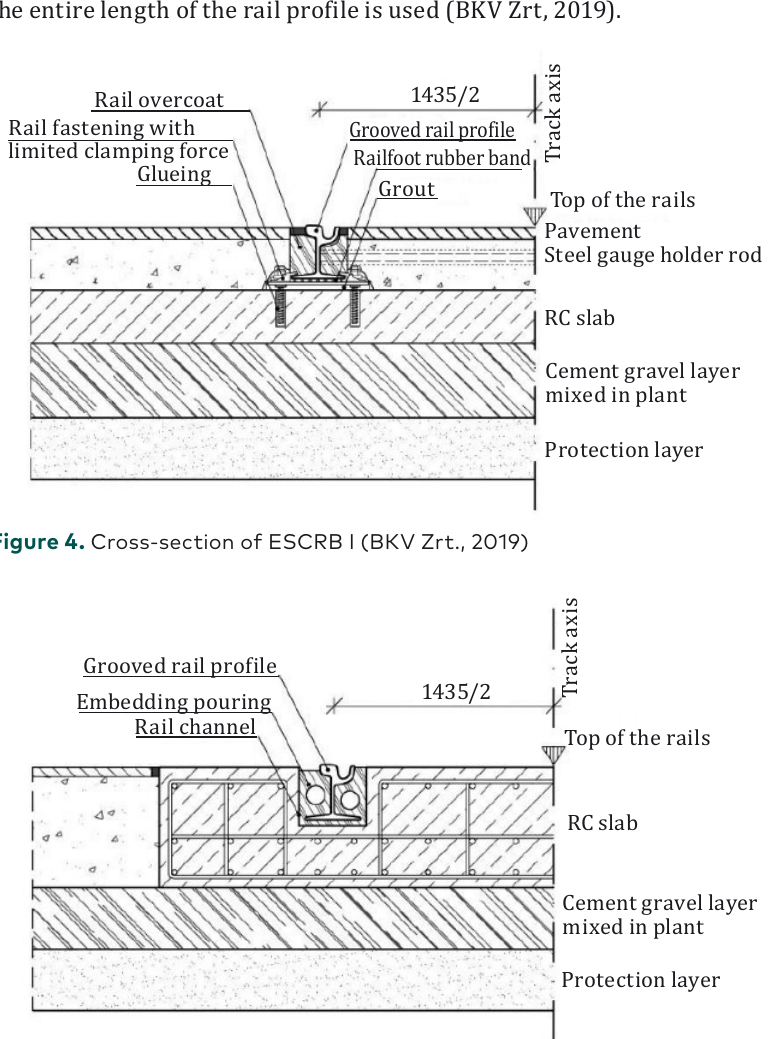
Figure 5. Cross-section of ESCRB III (BKV Zrt., 2019)